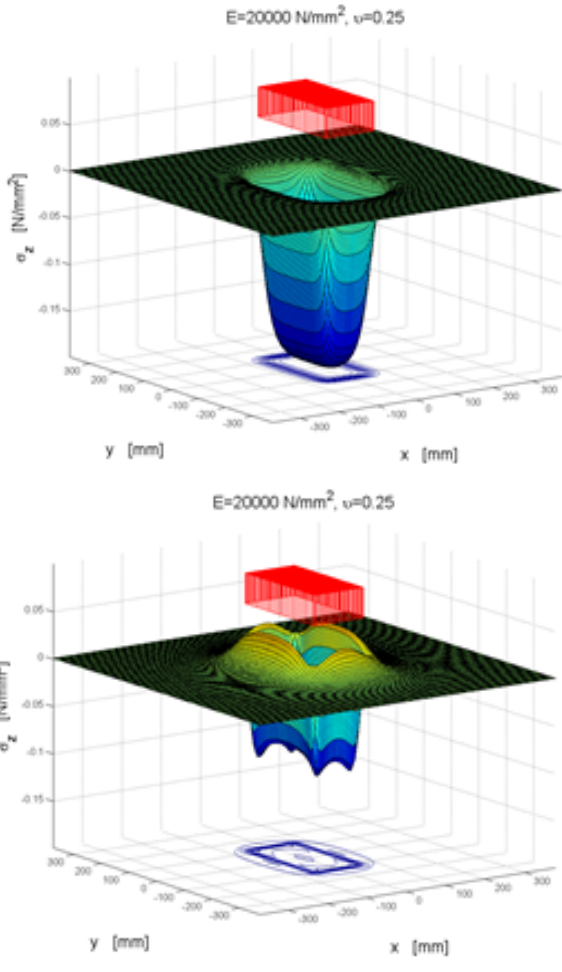
Figure 16: 3-D surfaces and stress contours of σ z near the surface: Boussinesq’s solution on the top and the second order solution on the